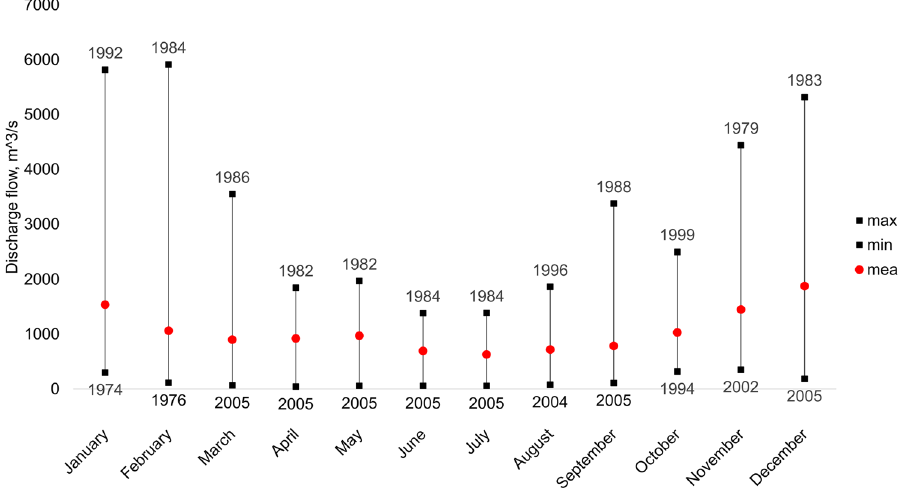
Fig. 1 Raw data tabulation in terms of maximum, mean, and minimum of monthly rainfall